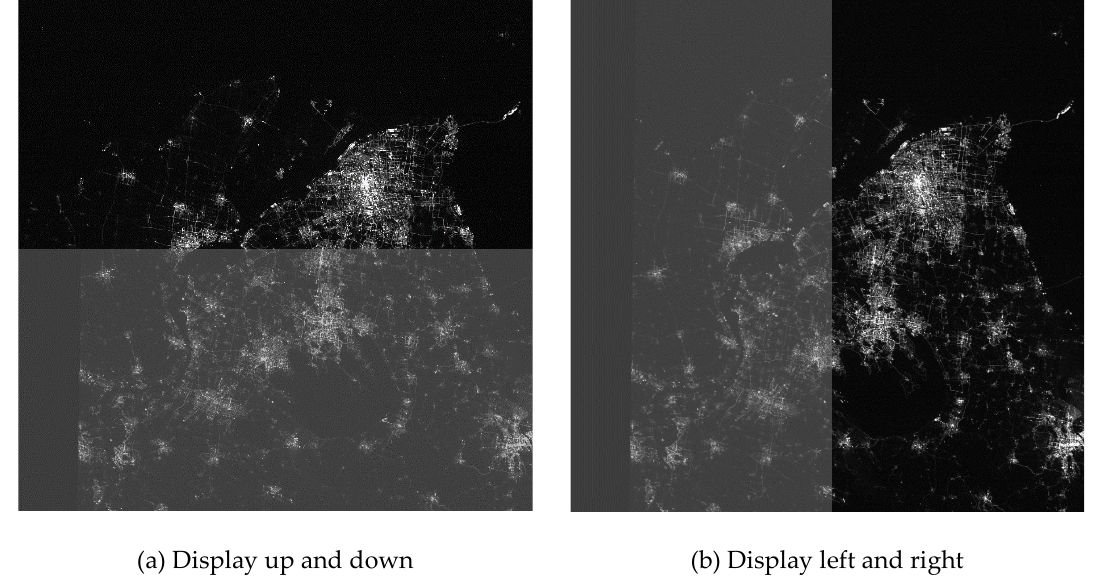
Figure 14. Shanghai shutter display after multi-temporal registration.